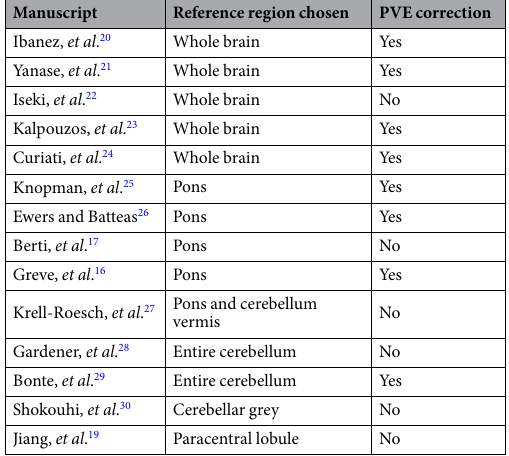
Table 1. Variability in choices of reference regions across healthy aging studies. Partial volume effect